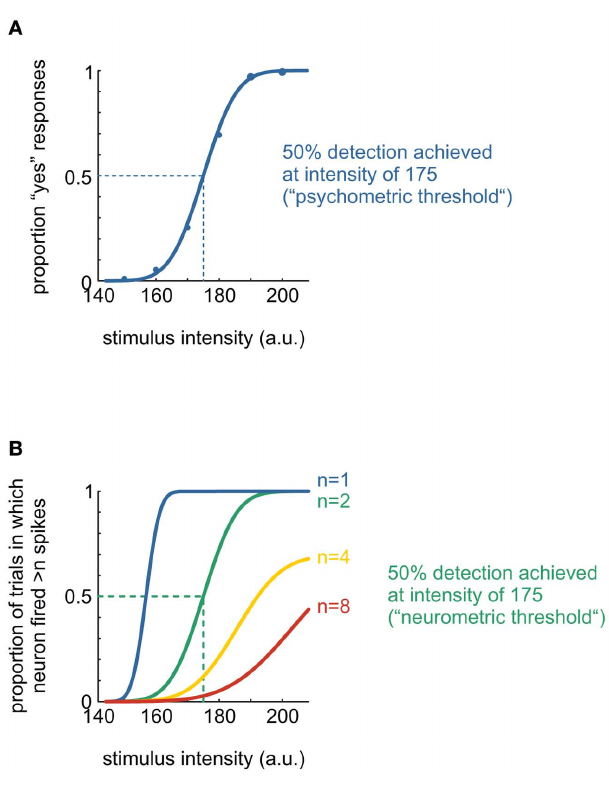
FIGURE 1 | Example illustration of a neurometric–psychometric comparison. (A) A typical psychometric curve from a yes/no detection experiment with six stimuli of varying intensity (see Box 1 ). Smooth line indicates fit of a cumulative Gaussian to the data points. Dotted line indicates the stimulus value at which the psychometric curve reaches 50% of its final height.This value is commonly taken as the psychophysical threshold. (B) Some typical neurometric curves: a single neuron’s spikes were counted during stimulus presentation.The neuron was assumed to “detect” the event when it fired in excess of n spikes during stimulus presentation, where n here encompasses 1, 2, 4, and 8 spikes.The neurometric curve for n = 2 matches the psychometric curve best, as assessed by their common threshold of 175 (arbitrary units).Thus, the NP ratio here is 175/175 =